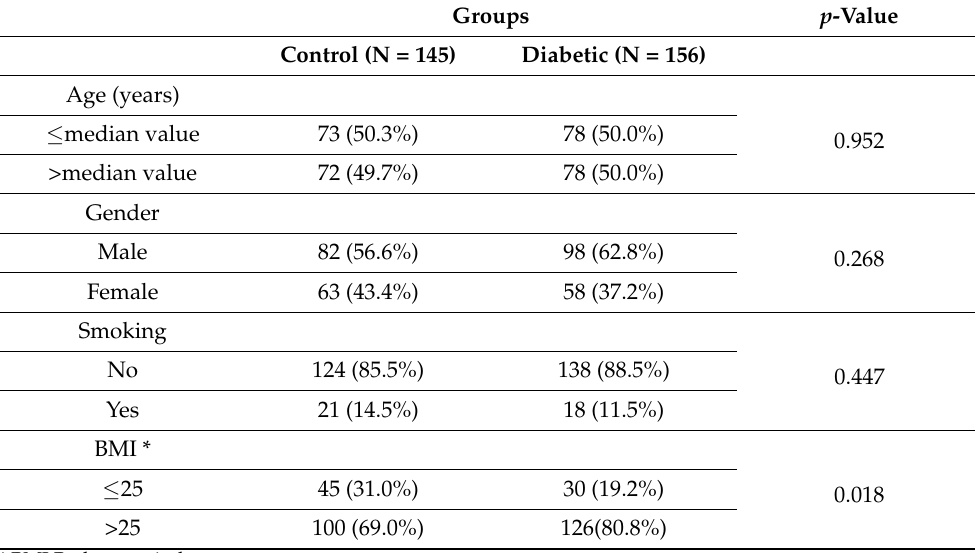
Table 1. Clinical Characteristics and Demographics of the Study Population.